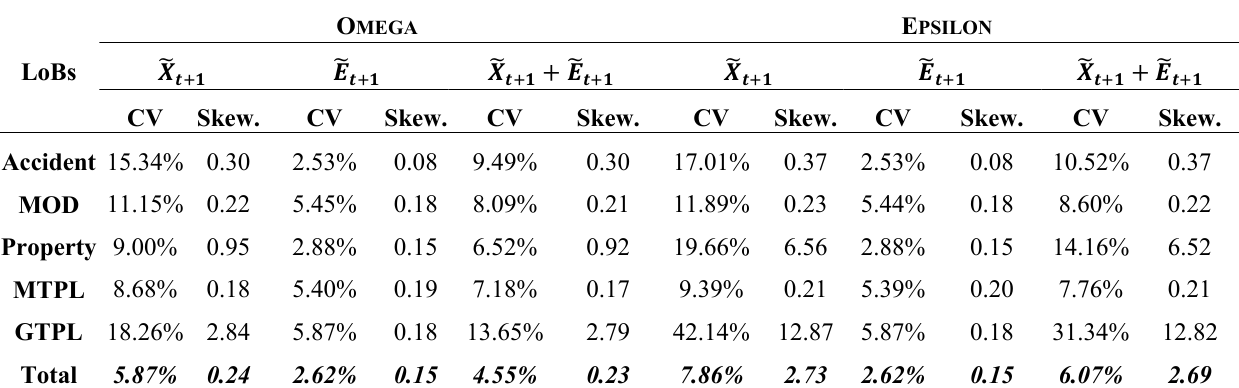
Table 4. CV and skewness of simulated distribution for each LoB (Gross of Reinsurance).